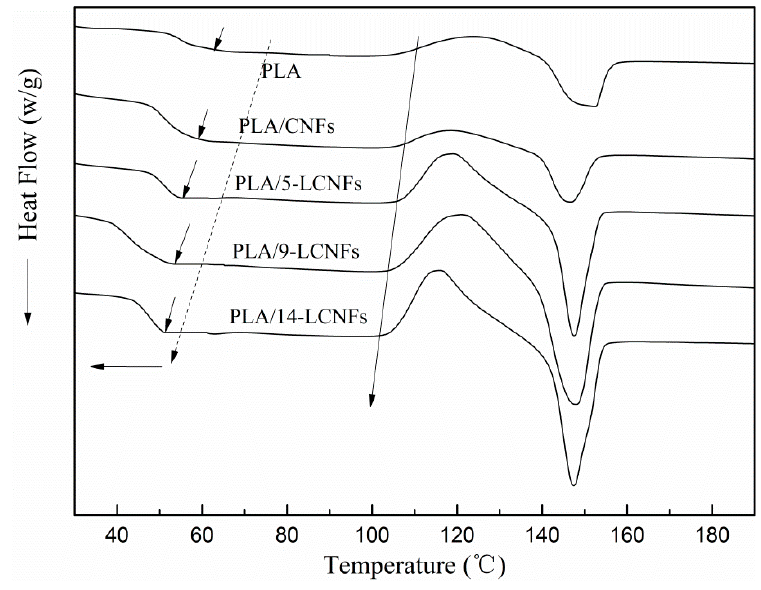
Figure 6. DSC curves of PLA and the PLA/LCNFs composites. Table 3. DSC data of PLA and PLA/LCNFs composites with different lignin contents.